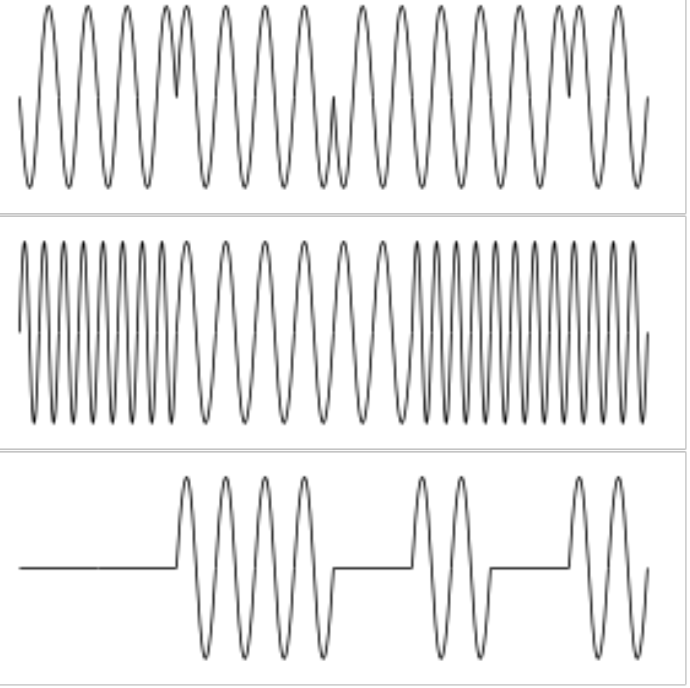
Figure 1. Modulation Puzzles using (top-to-bottom) PSK, FSK and OOK.